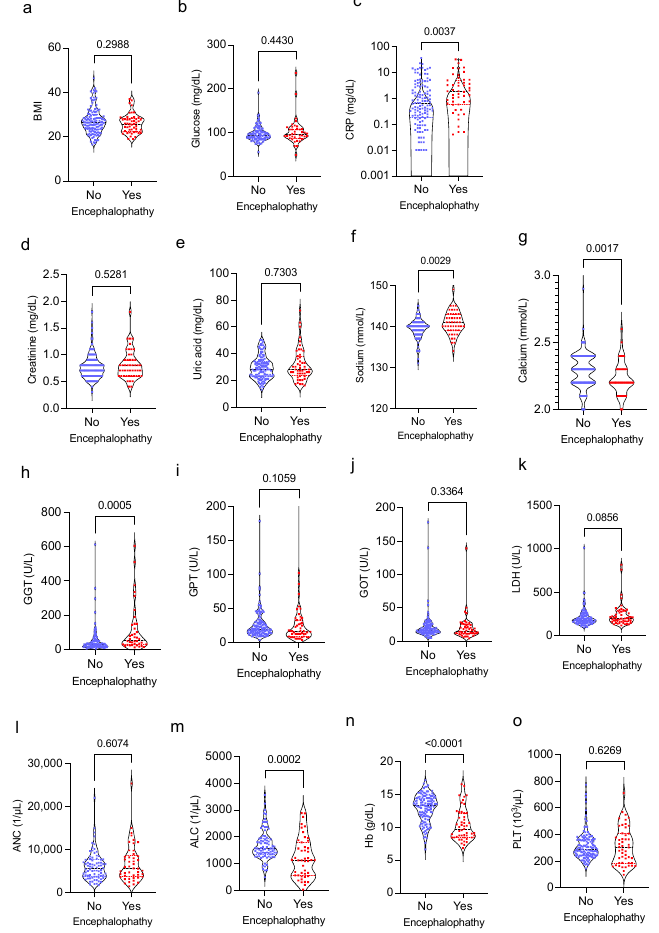
Figure 2. Correlation of clinical and laboratory parameters and IIN. ( a ) Correlation of BMI and IIN. ( b ) Association of glucose level, CRP ( c ), creatinine level ( d ), uric acid ( e ), sodium ( f ), calcium ( g ), GGT ( h ), GPT ( i ), GOT ( j ) LDH ( k ), ANC ( l ), ALC ( m ), Hb ( n ), and PLT count ( o ) and the occurrence of IIN. BMI = body mass index; IIN = ifosfamide-induced neurotoxicity; CRP = C-reactive protein; GGT = gamma-glutamyl transferase, GPT = glutamic pyruvic transaminase = alanine aminotrans- ferase; GOT = glutamic oxaloacetic transaminase = aspartate aminotransferase; LDH = lactate dehy- drogenase; ANC = absolute neutrophil count; ALC = absolute lymphocyte count; Hb = hemoglobin level; PLT = platelet.